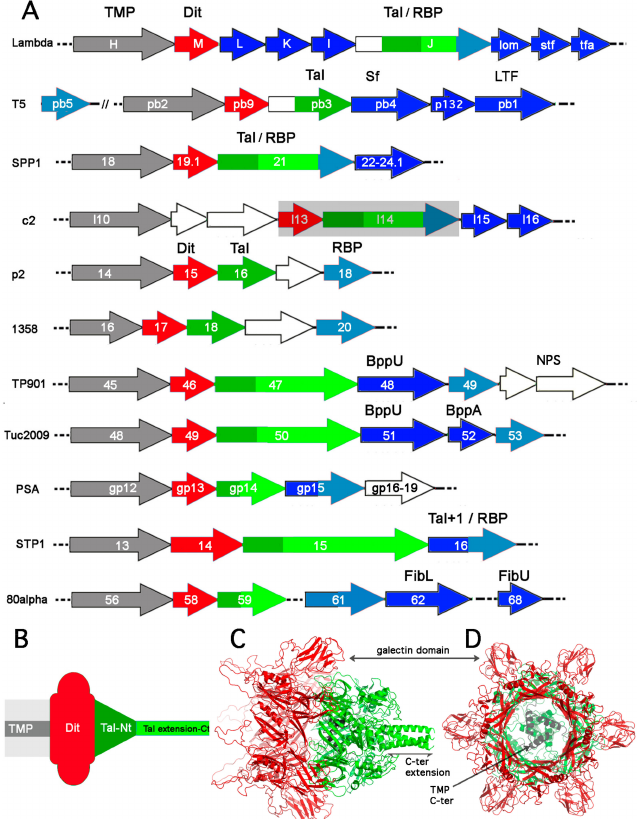
Figure 2. The adhesion device of siphophages. ( A ) Schematic representation of genes coding for the adhesion device of representative phages: lambda [7], T5 [9], SPP1 [9], c2 [23], p2 [24], 1358 [25], TP901-1 [21,26], Tuc2009 [27], PSA [13], STP1 [28], 80 α [15]. Tape measure proteins (TMPs) are color-coded grey; distal tail proteins (Dits) are color-coded red; tail-associated lysozymes (Tals) are color-coded dark green (Nt-structural domain), light green (Tal extension), light blue for Tal extension tip bearing a receptor-binding domain; receptor-binding proteins (RBPs) are color-coded light blue; ancillary proteins and tail fibers are color-coded dark blue. White genes are non-structural. The c2 phage Dit and Tal are shaded grey as their annotation is highly hypothetic; ( B ) Schematic topology of the TMP-Dit-Tal triad (same color code as in ( A )); ( C ) Example of a TMP-Dit-Tal triad from phage 80 α baseplate [15] (same color code as in ( A ) and ( B ). The TMP is dark grey); ( D ) 90 ◦ rotation with respect to